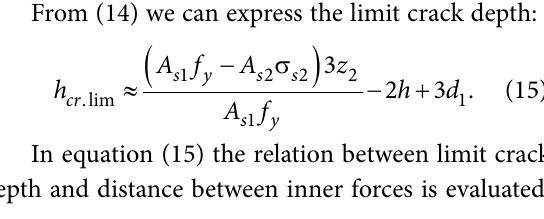
Fig. 10. Internal forces: a) using triangular concrete compressive zone stress diagram; b) using curved concrete compressive zone stress